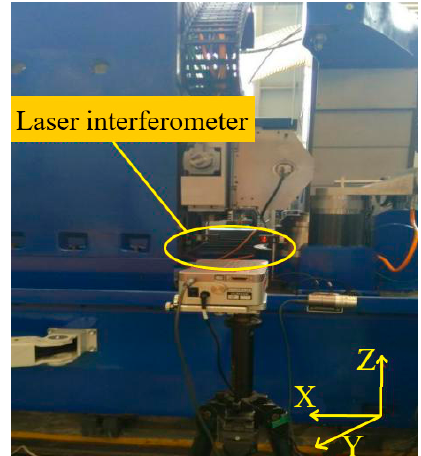
Figure 3. Measurement of axial geometric displacement errors δ xx.